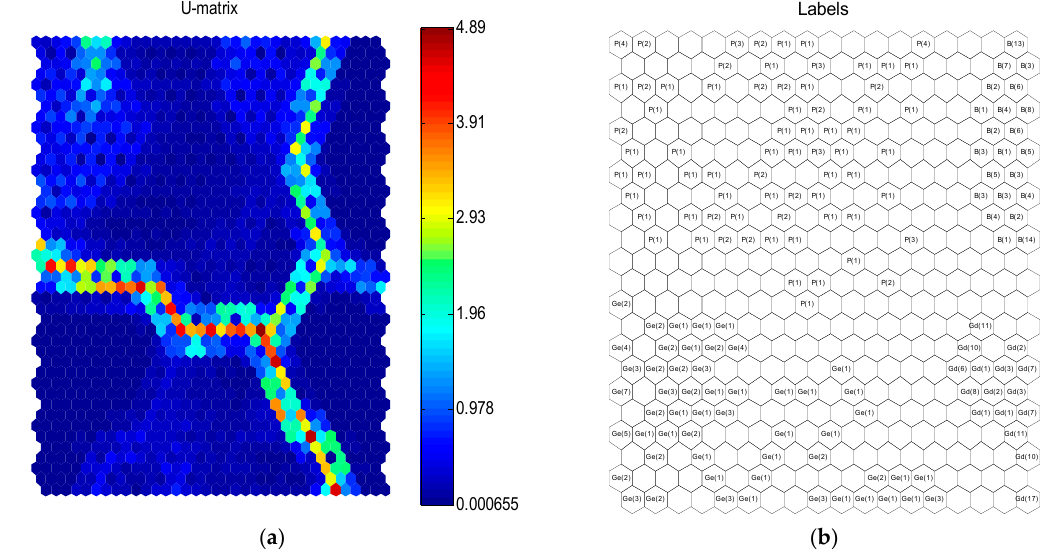
Figure 6. Visual monitoring model based on operator experience. ( a ) U-matrix map; ( b ) training